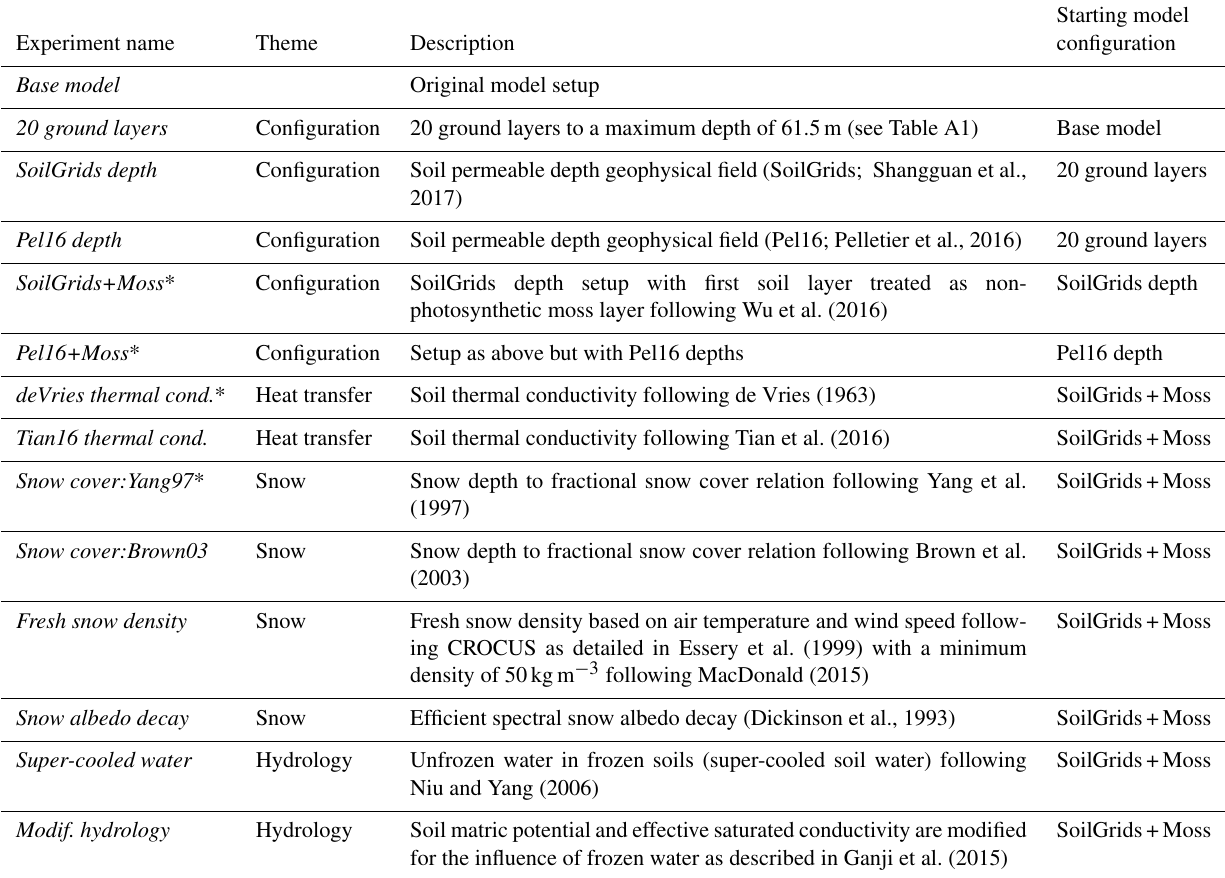
Table 1. List of experiments and the associated model theme they relate to. Experiments denoted with an asterisk were run with both the Climate Research Unit – National Centers for Environmental Prediction (CRUNCEP) and the Climate Research Unit – Japanese 55-year Reanalysis (CRUJRA55) meteorological forcing